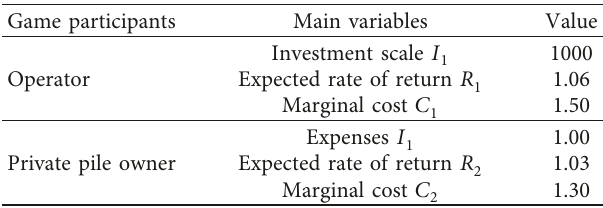
Table 3: Initial values of